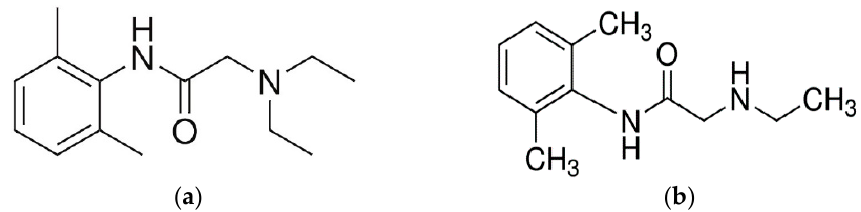
Figure 1. ( a ) Chemical structure of lidocaine; ( b ) Chemical structure of MEGX.